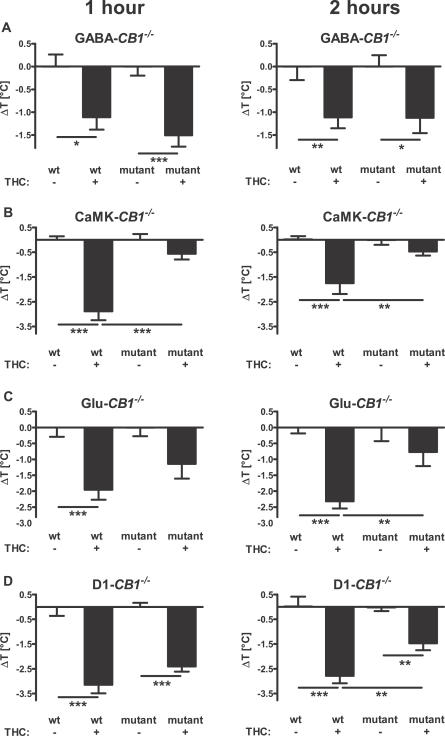
Effect of THC on Body Temperature of Different CB1 Mutant MiceBody temperature was measured with an infrared thermometer before injection (see text), 1 h (left panels) and 2 h (right panels) after the injection of 10 mg/kg of THC or vehicle. Values represent the difference of the body temperature of each animal with the mean of the respective vehicle-treated animals. *, **, ***; p < 0.05, p < 0.01, p < 0.001, respectively (two-way ANOVA, followed by Newman-Keuls post-hoc test). Note that THC has a normal effect in GABA-CB1
−/− (A), but impaired (weaker and/or short lasting) effect in CaMK-CB1
−/− (B), in Glu-CB1
−/− (C), and in D1-CB1
−/− mice (D). See Materials and Methods for number of animals in each group.